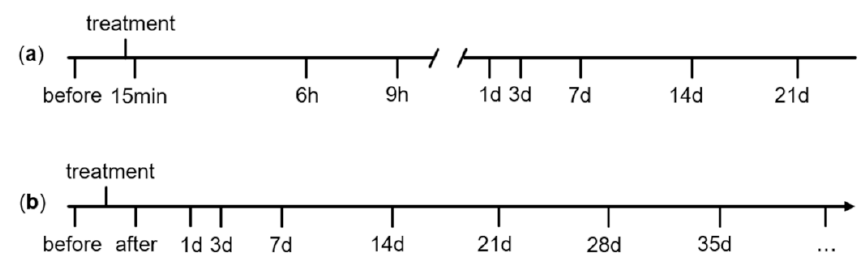
Figure 2. Time points of the measurement of the mechanical nociceptive threshold ( a ) and horn growth, wound healing and local tissue alterations ( b ). The latter measurements were repeated once weekly as long as the calf was at the